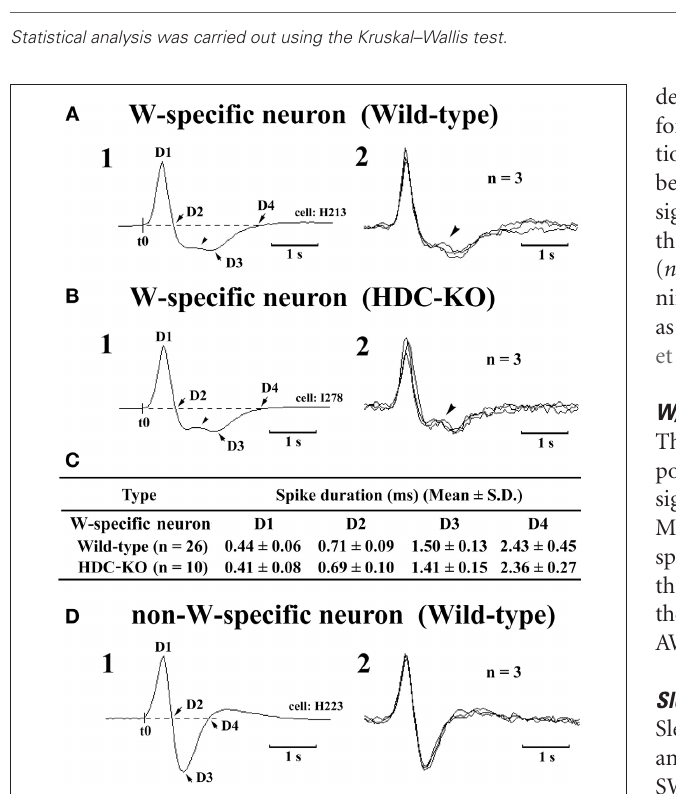
Figure 3 | Spike shape of W-specific neurons in Wild-type (A) and HDC-KO (B) mice and of W-active neuron in Wild-type mouse (D). Note that, in both wild-type and HDC-KO mice, W-specific neurons are characterized by a broad triphasic action potential, whereas W-active neuron displays a narrow biphasic action potential. The arrowheads indicate a positive deflection. C, Note that the difference in spike duration for the W-specific neurons in wild-type and HDC-KO mice (C) was not statistically different ( P > 0.1, Mann-Whitney) D1–D4 indicate the duration of the averaged action potential measured from onset ( t ) to the positive peak (D1), the first zero 0 crossing (D2), the negative peak (D3), or the second zero crossing (D4).